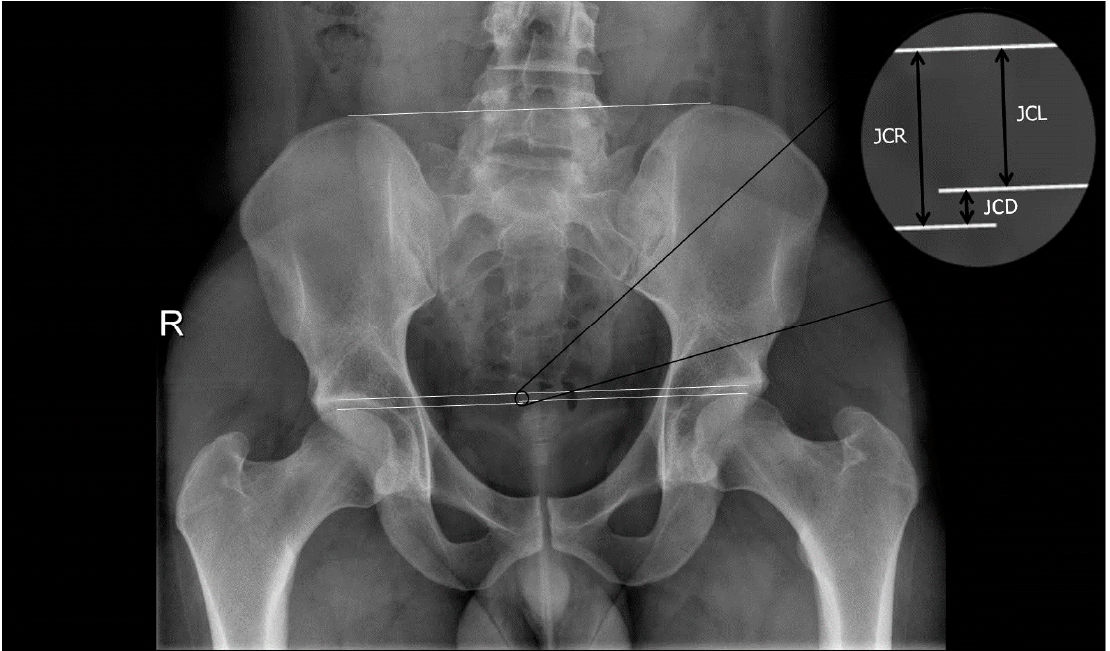
Figure 1. X-rays to quantify difference in the joint clearance. JCD: Joint clearance discrepancy; JCL: Joint clearance left; JCR: Joint clearance right.